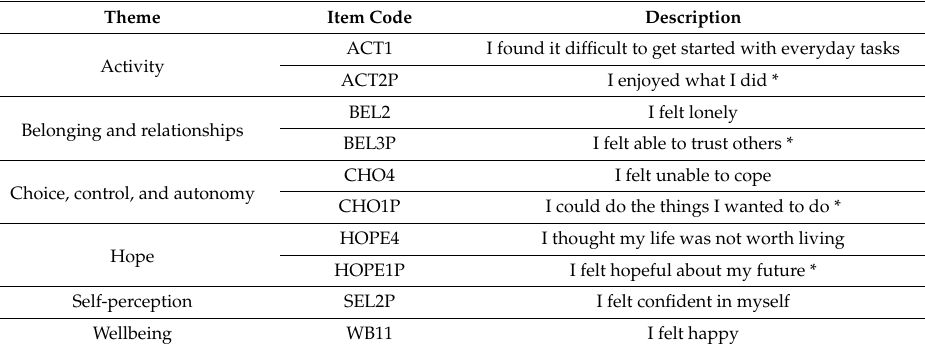
Table 3. Items chosen under each theme.